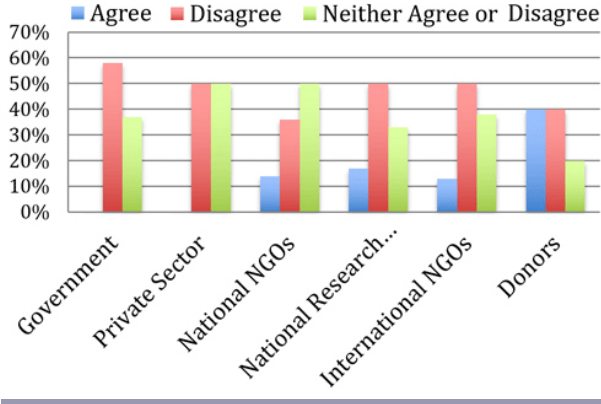
Fig. 1 . Responses to the statement that REDD+ should reward large businesses for achieving emission reductions. Percentage measures by actors